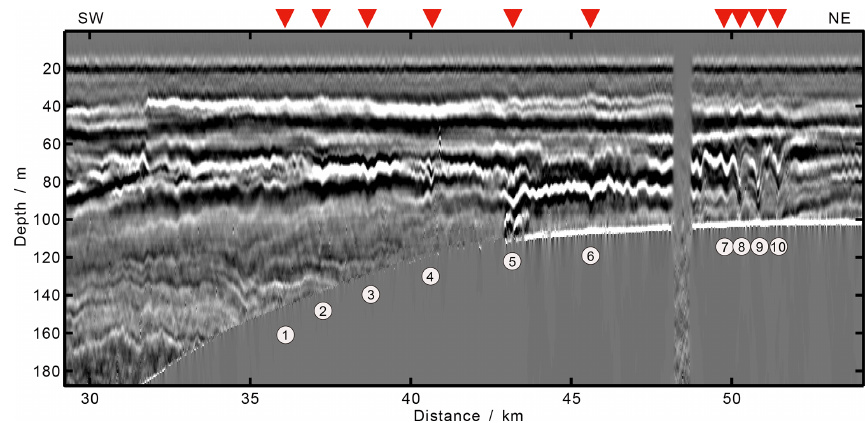
Figure 3. Seismic stacked section S1, with observed mode-2 ISWs on the survey line L84. Arrows and numbers indicate the 10 identified mode-2 ISWs ISW1–ISW10. The location of the S1 seismic stacked section is shown in Fig. 1. The horizontal axis indicates the distance to the starting point of survey line L84. The survey line L84 acquisition time was from 07:15:14GMT on 17 December 2004 to 17:26:49GMT on 17 December 2004. Table 1. Characteristic parameters of the 10 mode-2 internal solitary waves in Survey Line L84.